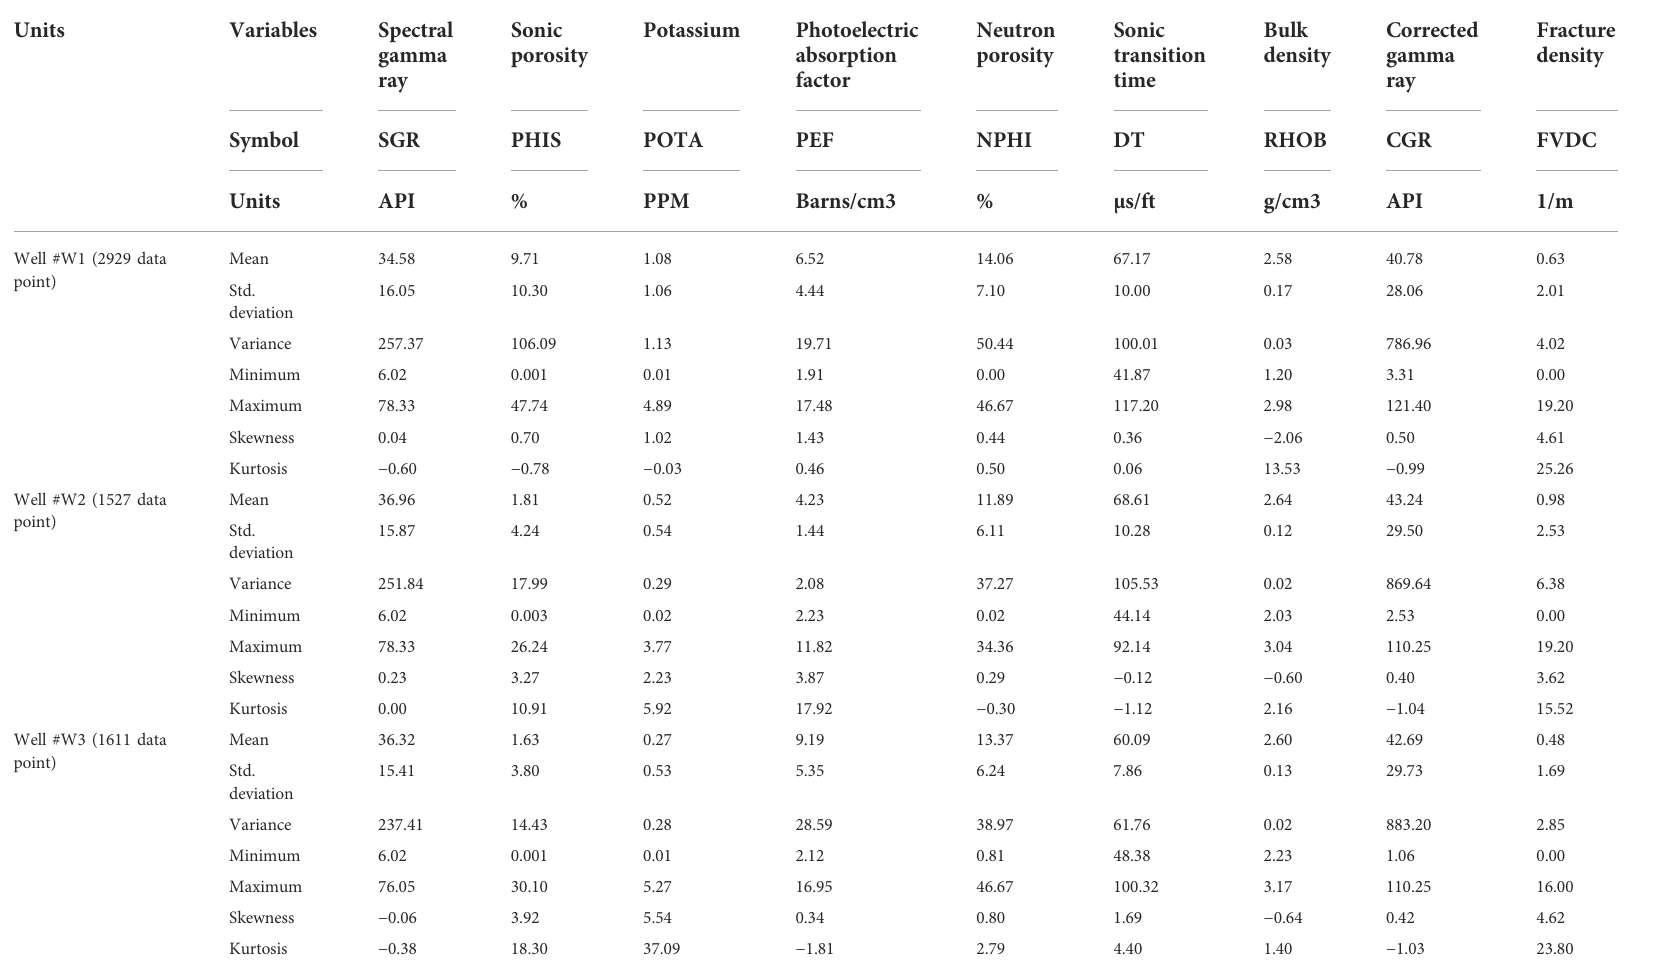
TABLE 5 Determination of statical parameter to prediction of FVDC of three wells of gas reservoirs located of Southwest Asia for each well seperatly (#W1, #W2 and #W3).